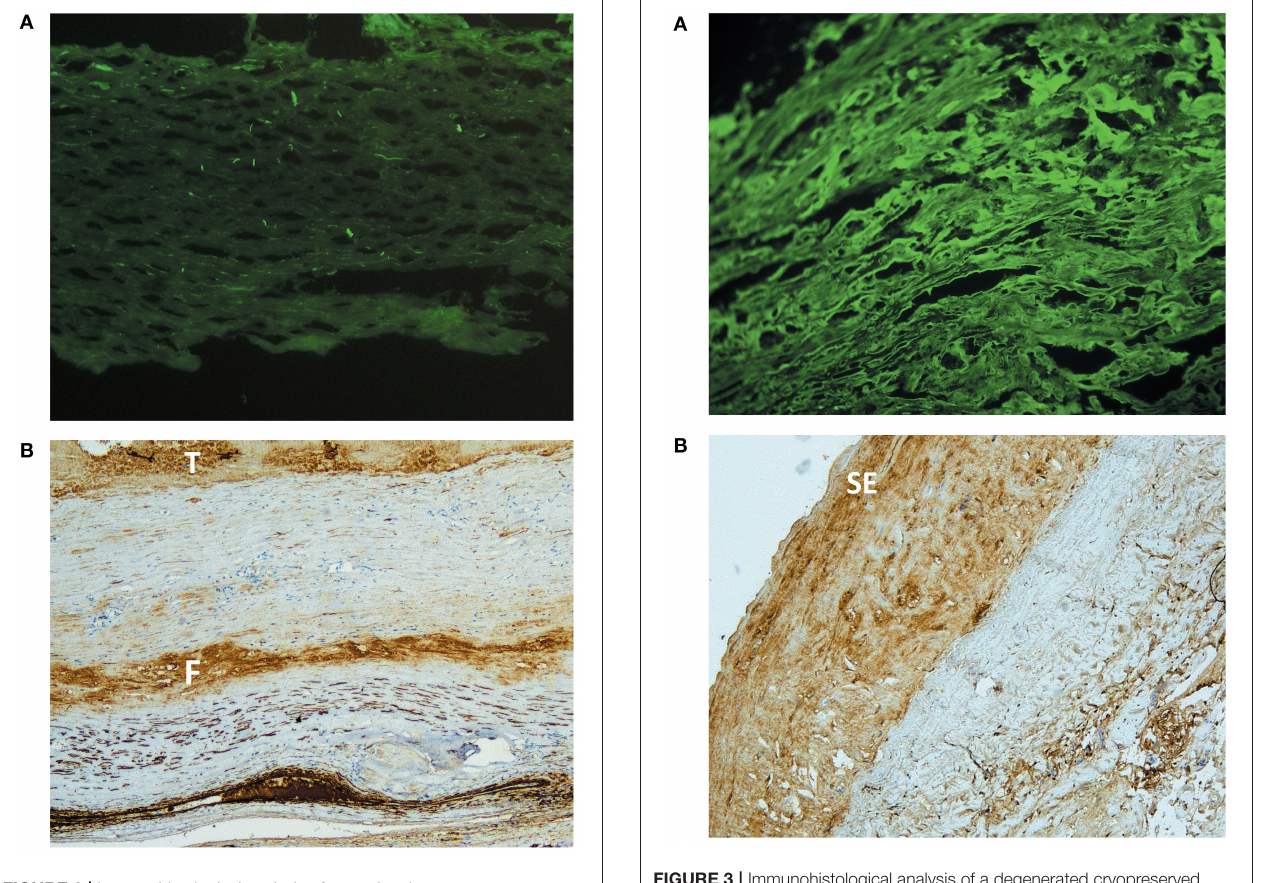
FIGURE 2 | Immunohistological analysis of control native artery aneurysms. (A) Immunofluorescence staining for IgG in a native humeral artery aneurysm. Homogenous distribution, suggesting the absence of immune complex deposition. Original magnification × 20. (B) Immunohistochemical staining for actin in a native popliteal artery aneurysm. The image shows a highly degenerated arterial wall in which the muscular layer has been mostly substituted by fibrous tissue (the F highlights a fibrin band). Intraluminal thrombus is marked with a T, and the darker layer at the bottom corresponds to an artifact. There is no evidence of immune complexes. Original magnification × 4.